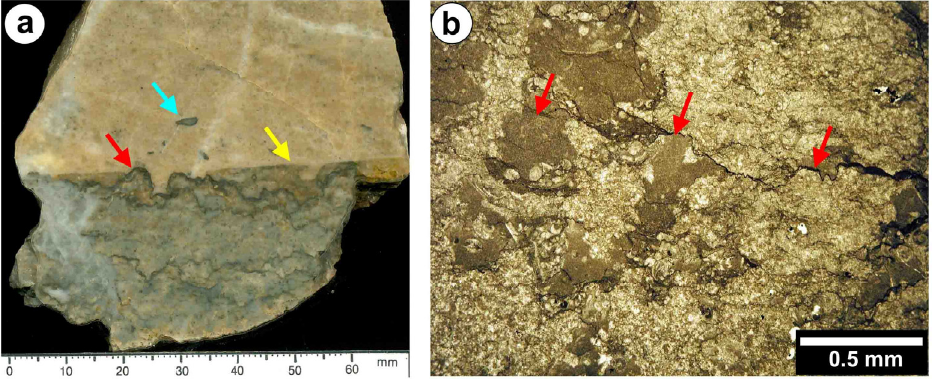
Figure 2. Details of effects of pressure solution in microbialites after the end-Permian extinction. ( a ) Vertical section of polished slab from the microbialite formed after the end-Permian extinction at Yudongzi site, NW Sichuan [9] showing microbialite (dark grey in lower part) overlain by fine-grained grainstone that has a flat erosion surface (yellow arrow) shortly above the microbialite; the erosion surface is followed by more grainstone containing intraclasts (light blue arrow) of microbialite limestone. Note the interruption of the sequence by prominent thick stylolites (red arrow) in the microbialite, making the precise interpretation of the sequence of events unclear. Also the erosion surface demonstrates loss of rock, indicating a potential problem for identification of submarine dissolution if ocean acidification affected these facies; ( b ) Thin section of microbialite from the Huaying Mountains of Sichuan, showing material has been removed along stylolites (red